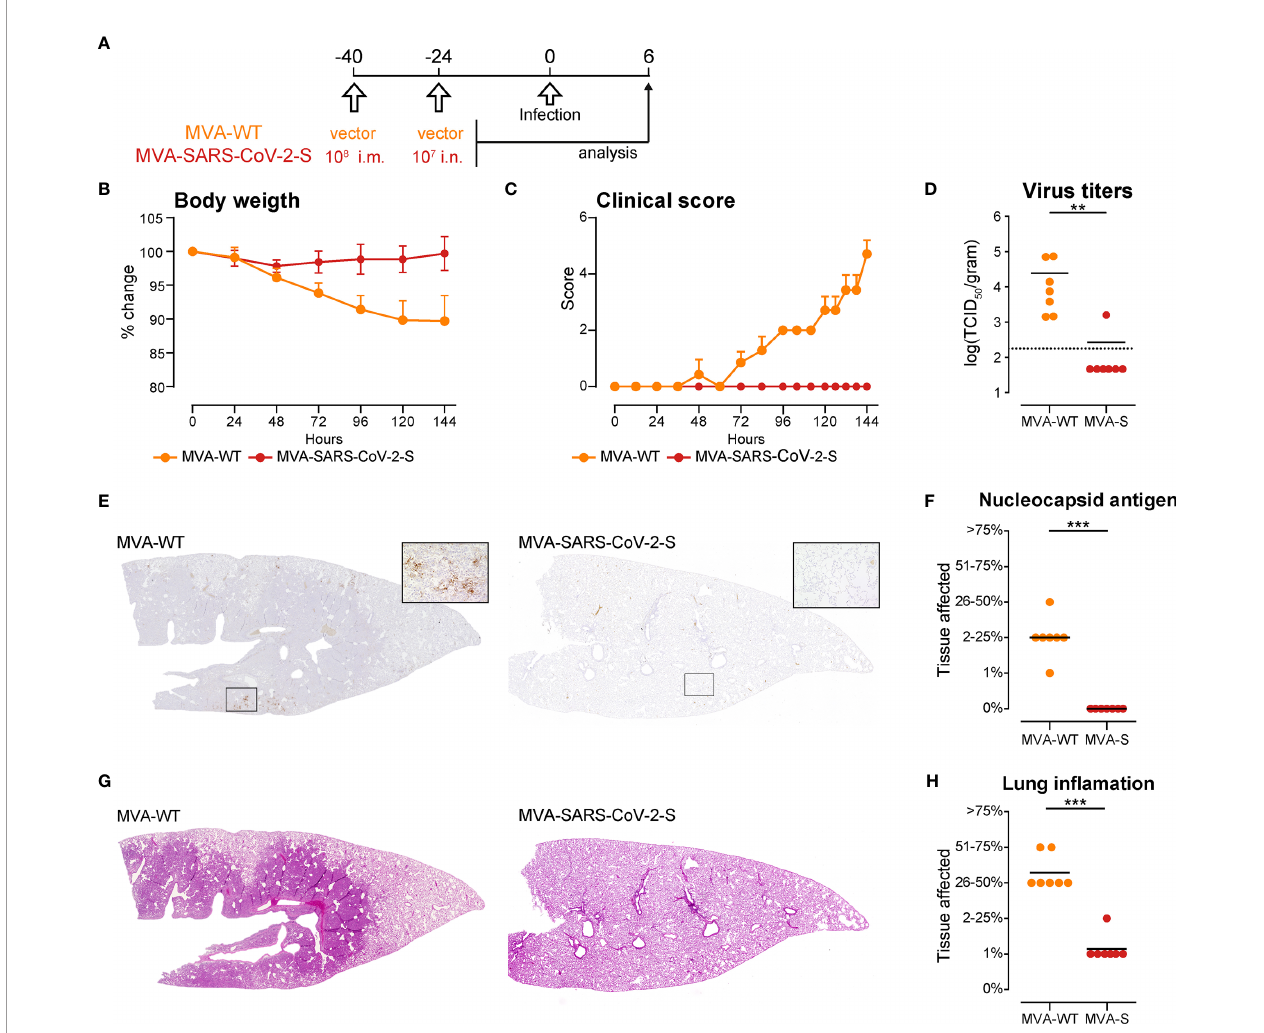
FIGURE 6 | Intranasal immunization with MVA-SARS-2-S protects hamsters from SARS-CoV-2 infection. (A) Immunization and infection protocol scheme. (B, C) Relative body weight (B) and clinical scores (C) of hamsters after infection with SARS-CoV-2. (D) SARS-CoV-2 virus titers in the lungs measured by quantitative RT-PCR. (E) Representative stitched photomicrographs showing an overview of the entire left lung lobe stained for SARS-CoV-2 nuceloprotein (brown staining). Original magni fi cation 40x, inset 400x. (F) Semiquantitative scoring of SARS-CoV-2 nuceloprotein per lung section averaged on 2 lung sections per hamster. (G) Representative stitched photomicrographs showing an overview of the entire left lung lobe stained with hematoxylin and eosin (H, E) indicate severe in fl ammation in the lungs of hamsters immunized with control, MVA-WT virus, which is almost not existent in the lungs of hamsters immunized with MVA-SARS-CoV-2. Original magni fi cation 40x. (H) Lung in fl ammation scores calculated as described supplemental methods. (B – H) Pooled data from one experiment with n = 7 per group. Individual values (signs) and mean group value (line). Statistical analysis was done using Mann-Whitney t test. **p < 0.01, ***p <